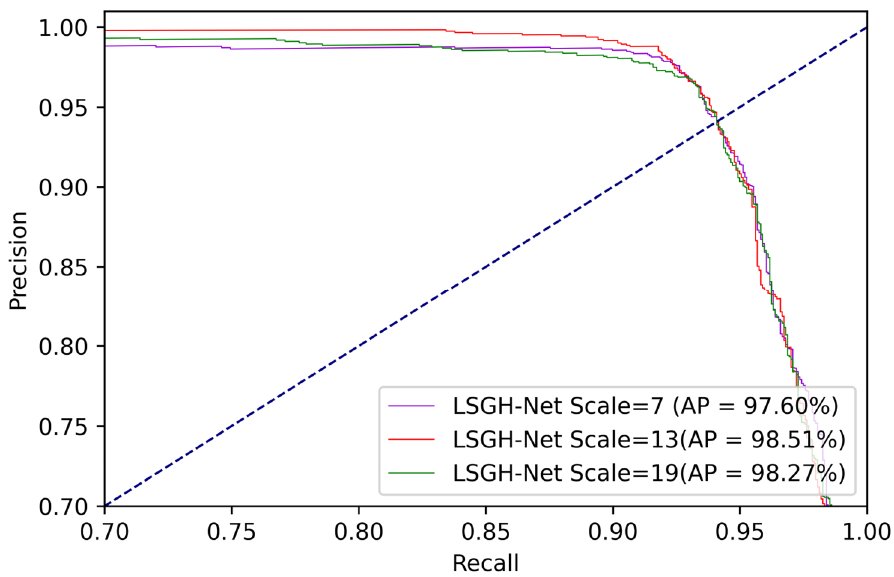
Figure 12. Comparison of multi-scale PR curves and AP values.